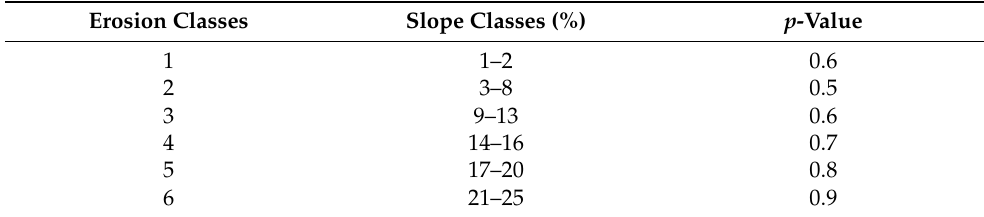
Table 3. p factor values for contouring practices for each slope class (from Kirkby and Morgan [72]). Erosion